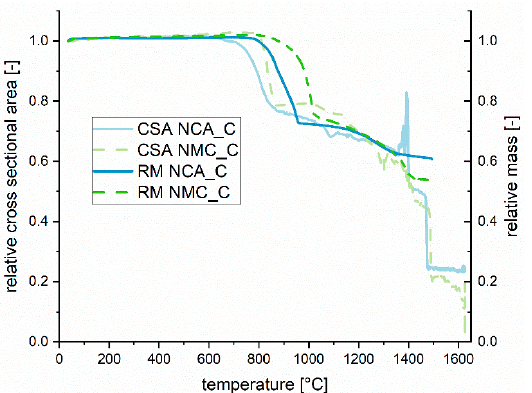
Figure 7. Trends of the cross-sectional area and the relative mass of NMC_C and NCA_C during heating in the heating microscope experiments and the simultaneous thermal analysis.